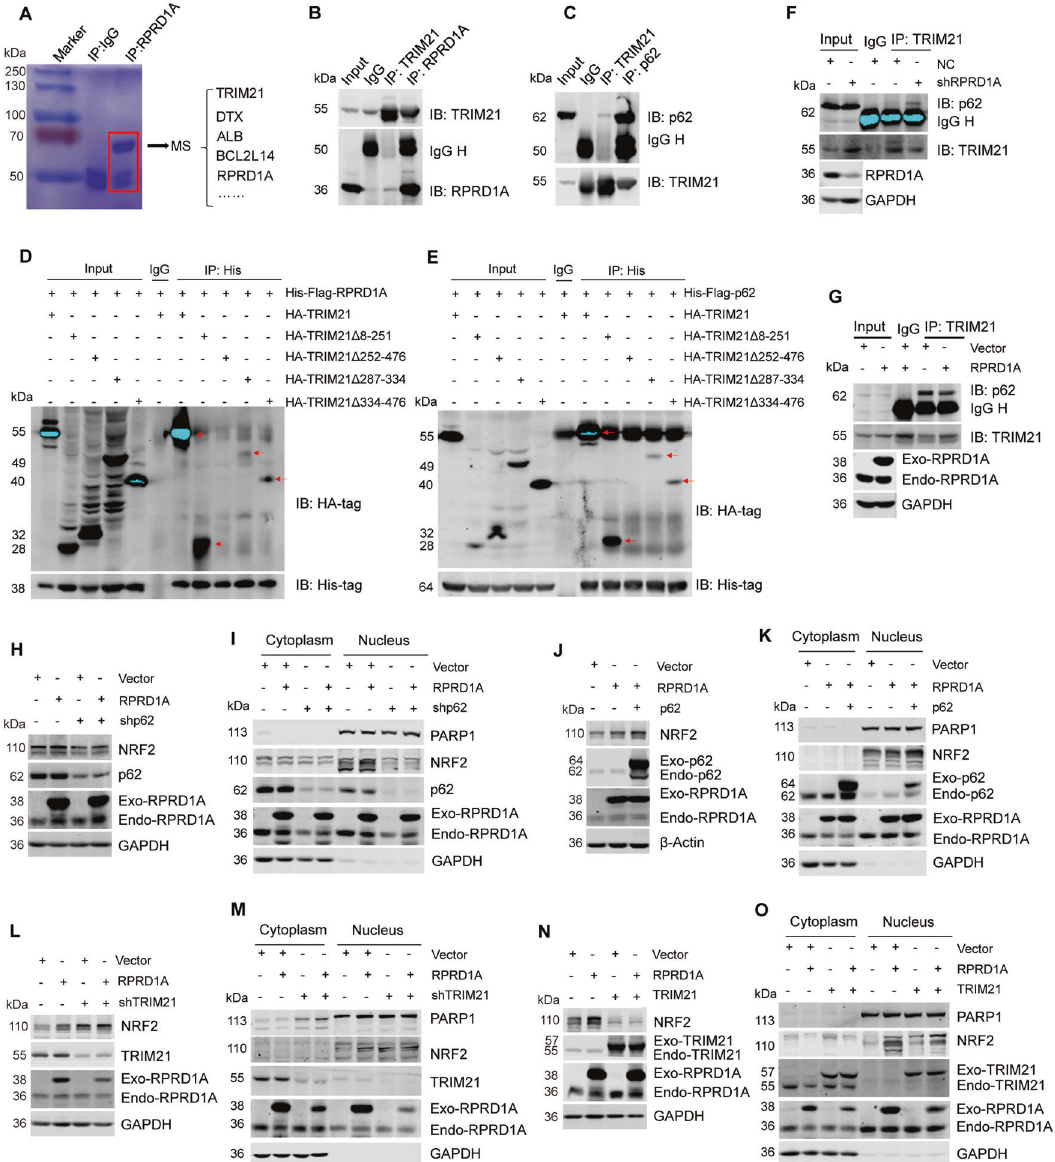
Fig. 5 RPRD1A competitively binds to TRIM21 to decrease the p62 ubiquitination and NRF2 degradation. A Potential protein interactions were analyzed by mass spectrometry. Immunoprecipitation was performed in MHCCLM3 cells with antibody against RPRD1A, and then isolated by SDS-PAGE and stained with coomassie brilliant blue. All indicated protein bands were excised for mass spectrometric analysis. B The endogenous interaction between RPRD1A and TRIM21. MHCCLM3 cells were subjected to co-IP assays using TRIM21 or RPRD1A antibody. The abundance of RPRD1A and TRIM21 in precipitate was detected by western blotting. C The endogenous interaction between p62 and TRIM21. MHCCLM3 cells were subjected to co-IP assays using p62 or TRIM21 antibody. D His-Flag-RPRD1A and HA-tagged TRIM21 full- length or truncation mutants were expressed in HEK293T cells for 48 h. Cell lysates were subjected to co-IP assays using His-tag antibody. E His-Flag-p62 and HA-tagged TRIM21 full-length or truncation mutants were expressed in HEK293T cells for 48 h. Cell lysates were subjected to co-IP assays using His-tag antibody. F , G Co-IP assays to detect the interaction between TRIM21 and p62 under the condition of RPRD1A knockdown ( F ) or overexpression ( G ). H , I Western blotting to detect the protein levels of NRF2 from the whole cell lysates ( H ), cytoplasm and nuclear fractions ( I ). Empty vector or His-Flag-RPRD1A plasmid was transfected into the control and p62-knockdown MHCCLM3 cells. J , K Western blotting to detect the protein levels of NRF2 from the whole-cell lysates ( J ), cytoplasm and nuclear fractions (K). Empty vector, His- Flag-RPRD1A, and p62 plasmids were transfected into MHCCLM3 cells. L , M Western blotting to detect the protein levels of NRF2 from the whole-cell lysates ( L ), cytoplasm and nuclear fractions ( M ). Empty vector and His-Flag-RPRD1A were transfected into the control and TRIM21- knockdown MHCCLM3 cells. N , O Western blotting to detect the protein levels of NRF2 from the whole-cell lysates ( N ), cytoplasm and nuclear fractions ( O ). Empty vector, His-Flag-RPRD1A and HA-TRIM21 were transfected into the MHCCLM3